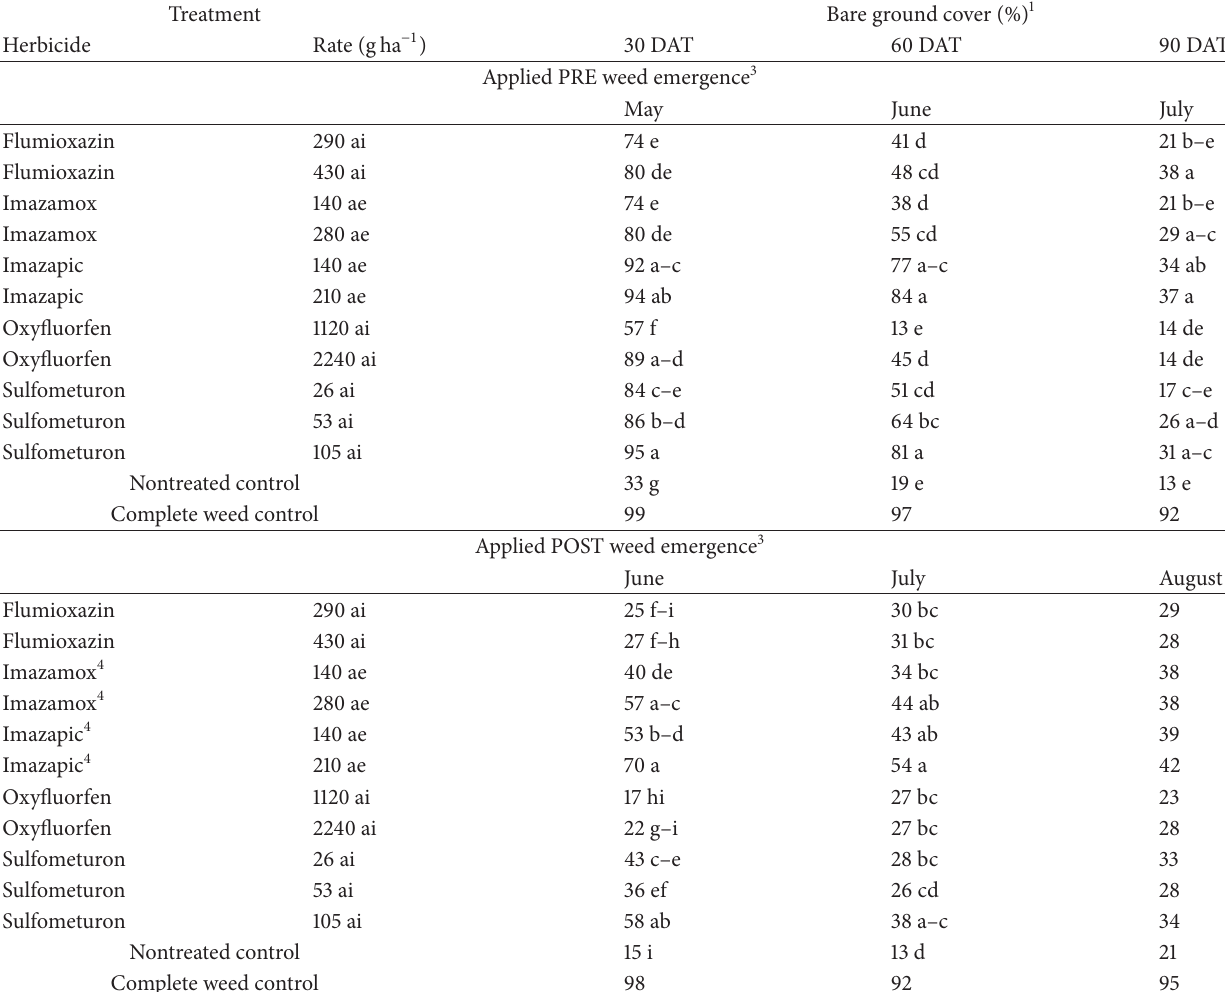
Table 2: Prevalence of bare ground 30, 60, and 90 days after treatment (DAT) for herbicides applied over newly planted Eucalyptus urograndis rooted cuttings either prior to weed emergence (PRE) or after weed emergence (POST). Treatments were evaluated at the end of the month indicated for each application timing and periodic